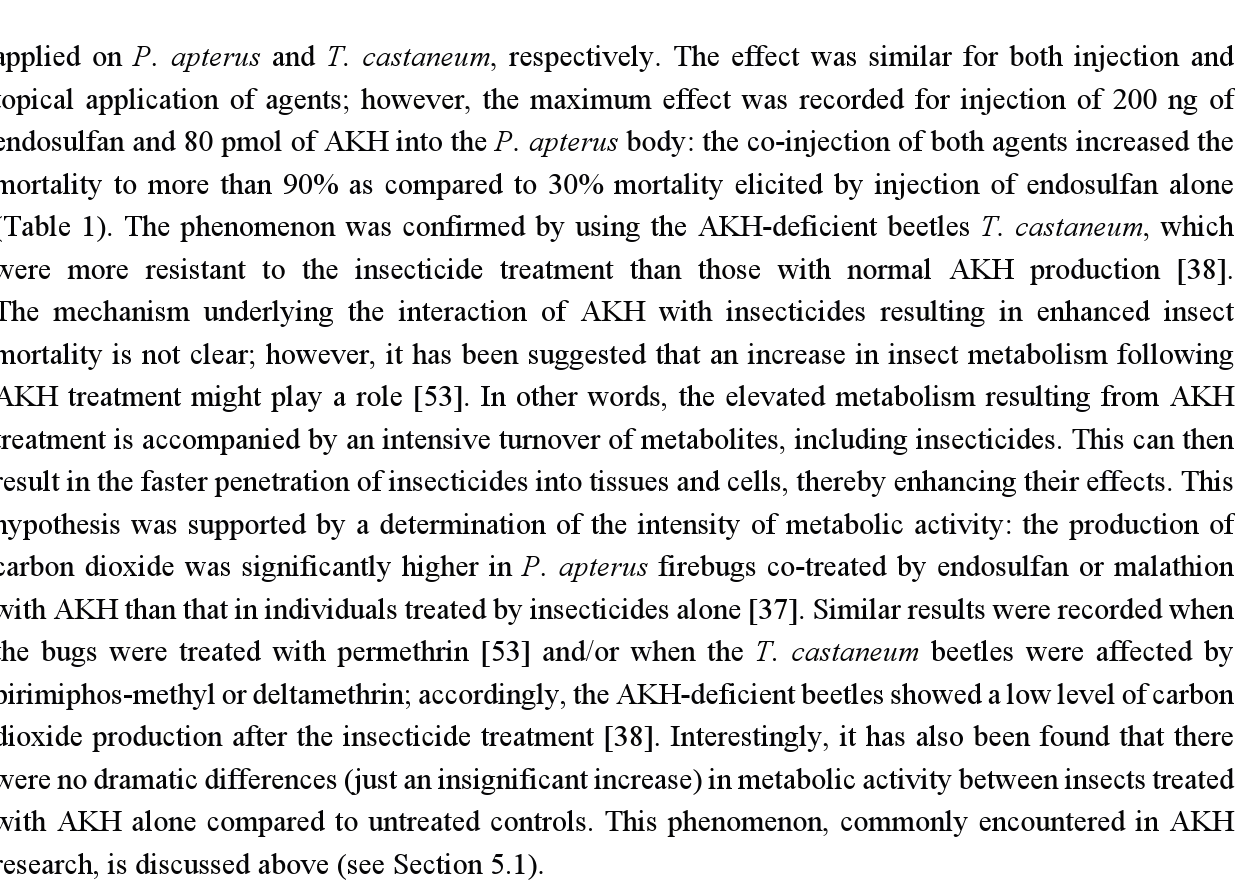
Table 1. Effect of insecticides permethrin (P), endosulfan (E), malathion (M), pirimiphos-methyl (PM), and deltamethrin (D), and their co-application with AKH, on mortality of the firebug P. apterus and the beetle T. castaneum . Increase of mortality—expressed as increase of percentage of mortality after the co-treatment insecticide + AKH as compared to the effect of insecticide alone; mortality ratio—is the ration between the two latter mentioned mortalities; abbreviations: inj—injection, top—topical application, res. film—application by residual film, dip—dipping, AKH-def.—beetles with AKH production deficiency; the